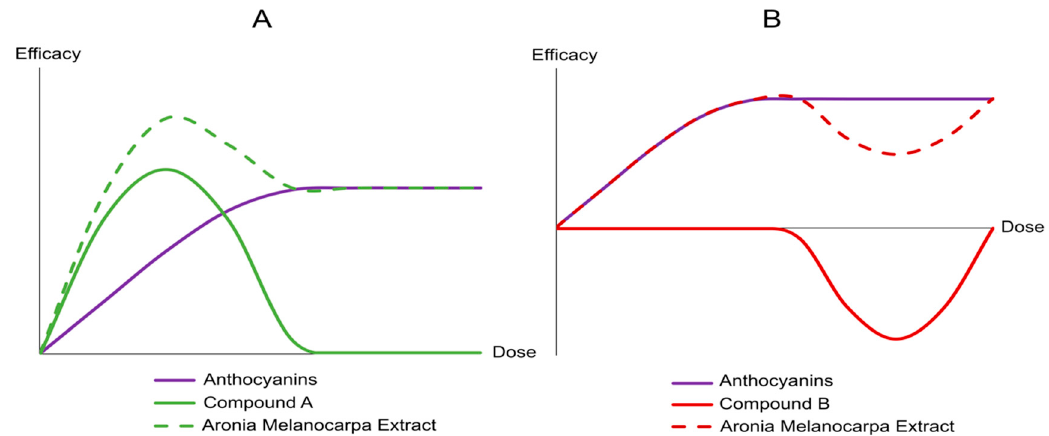
Figure 6. Theoretical explanations for di ff erences in e ff ectiveness of Aronia melanocarpa extract supplementation at di ff erent doses. Panel A : Compound A could beneficially impact the e ff ect of Aronia melanocarpa at lower doses. Panel B : Compound B could negatively a ff ect Aronia melanocarpa at higher doses.